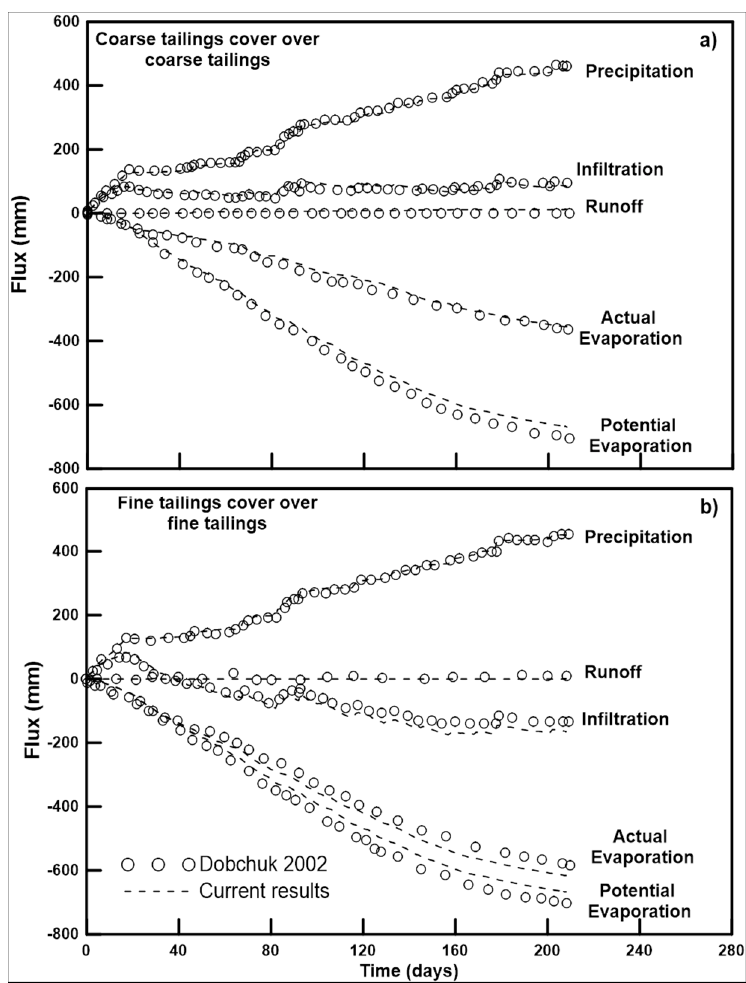
Figure 6. Water balance at the ground surface for verification of ( a ) coarse and ( b ) fine tailing covers.